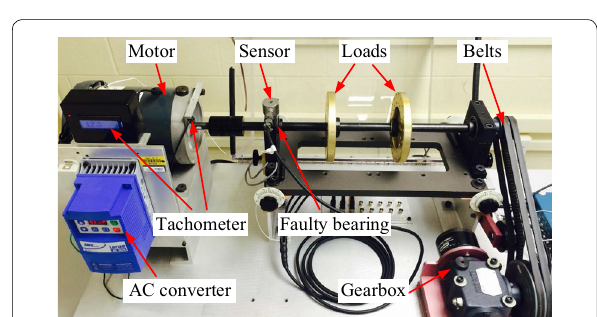
Figure 7 Experimental setup for bearing fault